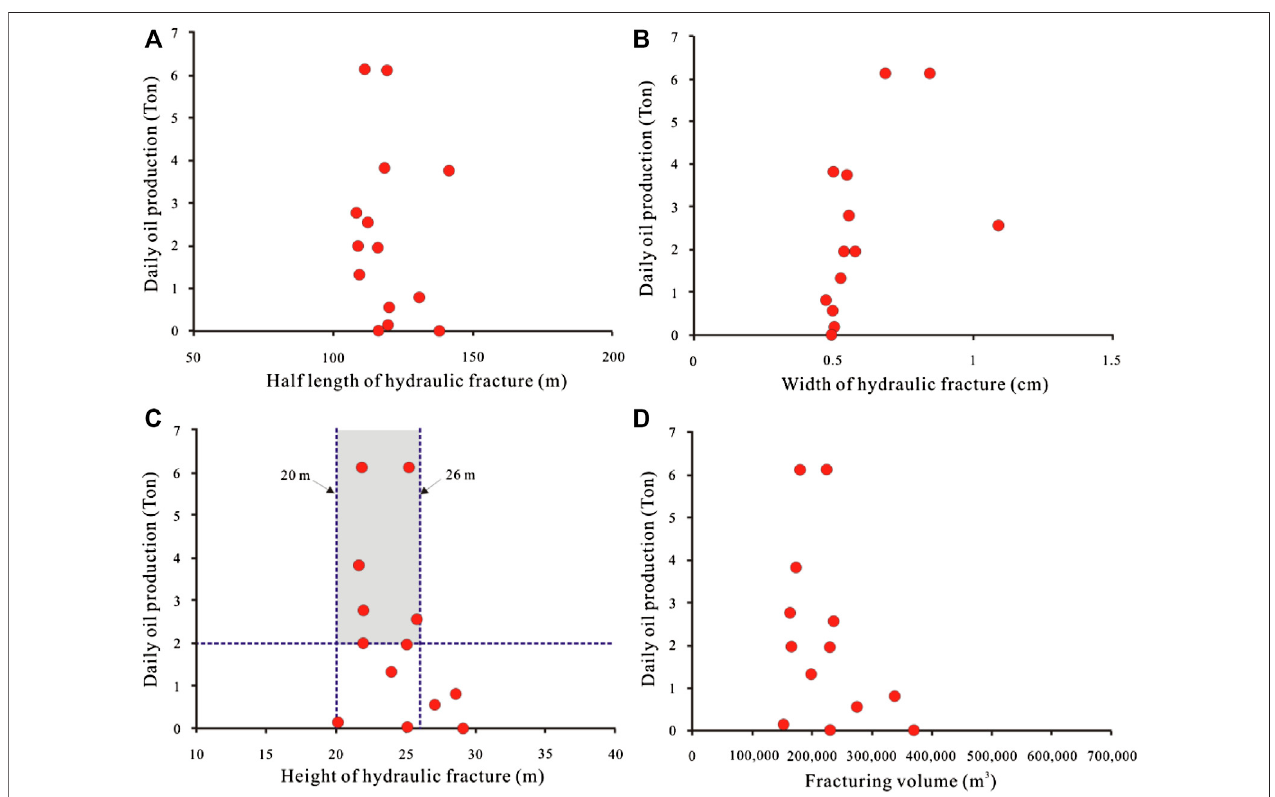
FIGURE 10 | Relationship between fracture parameters and productivity of fractured